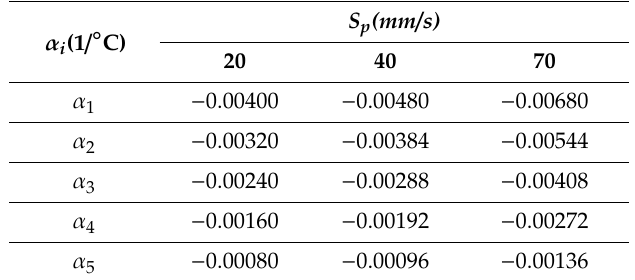
Table 3. Thermal expansion coe ffi cients for di ff erent printing